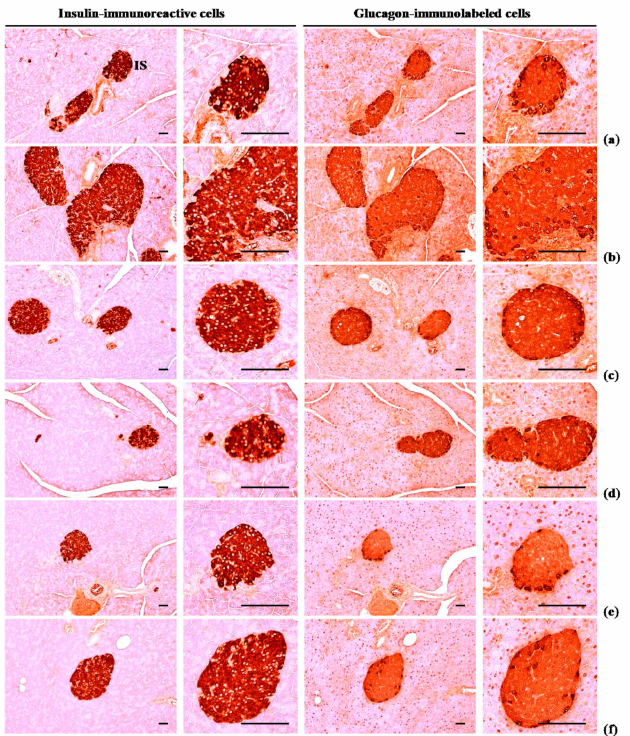
Figure 7. Representative histological images of the insulin- and glucagon-immunoreactive cells in the pancreas, taken from NFD or HFD supplied mice. ( a ) Vehicle (distilled water) 10 mL / kg orally administered mice with NFD supply (Intact control); ( b ) Vehicle 10 mL / kg orally administered mice with HFD supply (HFD control); ( c ) 250 mg / kg of metformin oral administered mice with HFD supply (Metformin); ( d ) WL 200 mg / kg orally administered mice with HFD supply (WL200); ( e ) WL 100 mg / kg orally administered mice with HFD supply (WL100); ( f ) WL 50 mg / kg orally administered mice with HFD supply (WL50). NFD = Normal pellet diet; HFD = 45% Kcal high-fat diet; WL = Wasabi Leaf / Folium, Wasabia japonica (Miq.) Matsum extracts; IS = Pancreatic islet. All immunostained by avidin-biotin-peroxidase complex. Scale bars = 80 µ